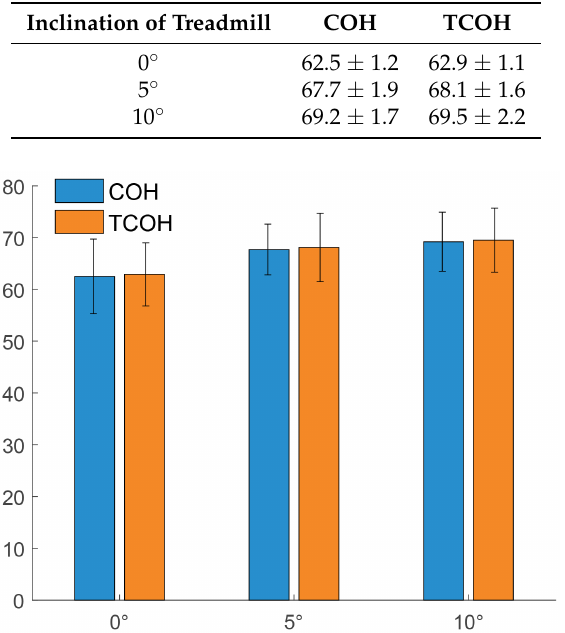
Table 7. TCOH calculated by the additional work done by the muscle.